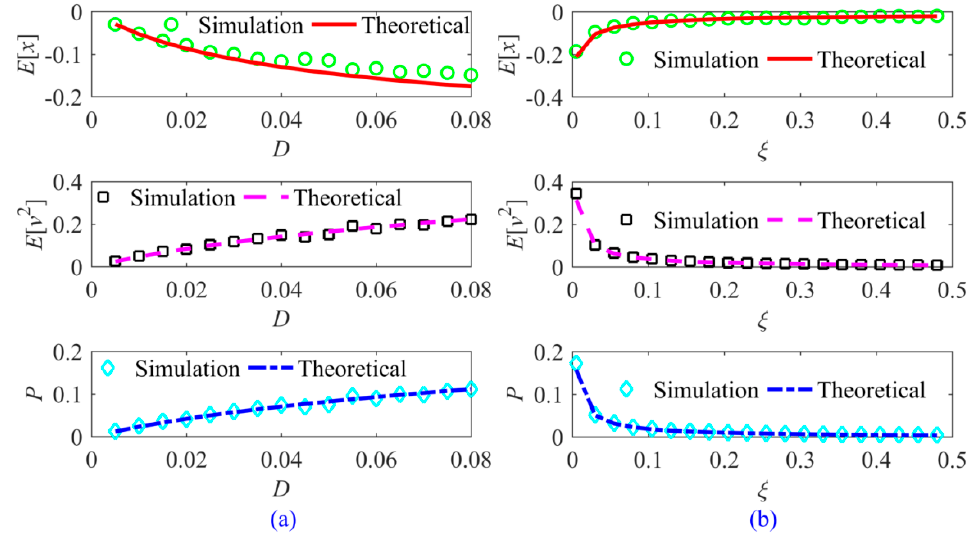
Figure 2. Influence of ( a ) noise intensity and ( b ) damping ratio on the mean displacement, mean square voltage, and power output.